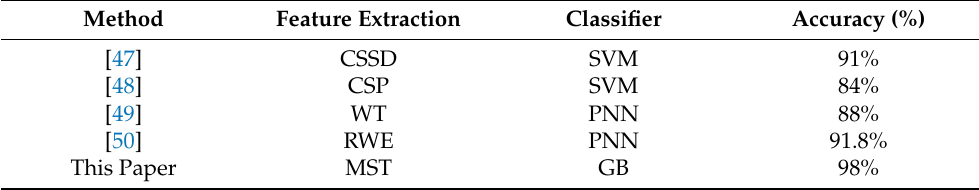
Table 2. Comparison of the classification accuracy of our method with other